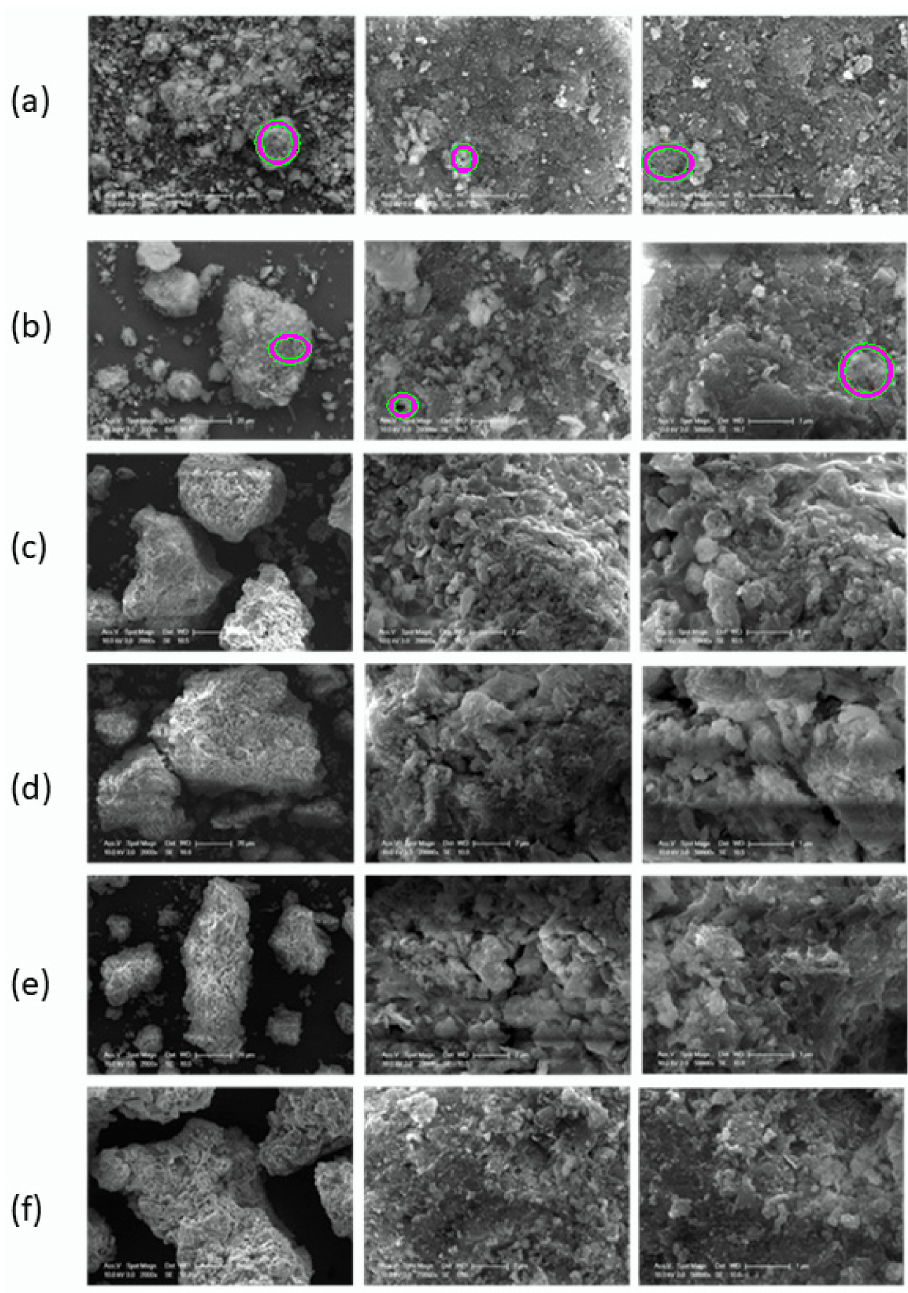
Figure 4. ESEM images of ( a ) D, ( b ) MD, ( c ) DC-11, ( d ) DC-12, ( e ) MDC-11, ( f ) MDC-12. EDAX spectral elemental composition of D, MD, and corresponding CeO 2